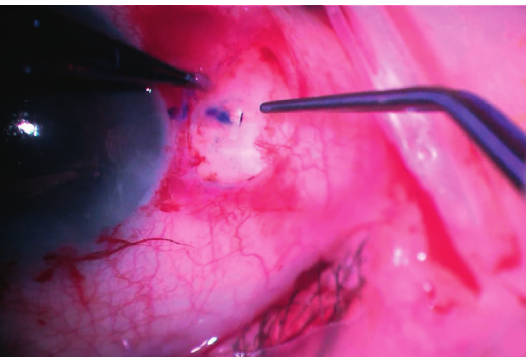
Figure 4: Transscleral plug placed in the scleral